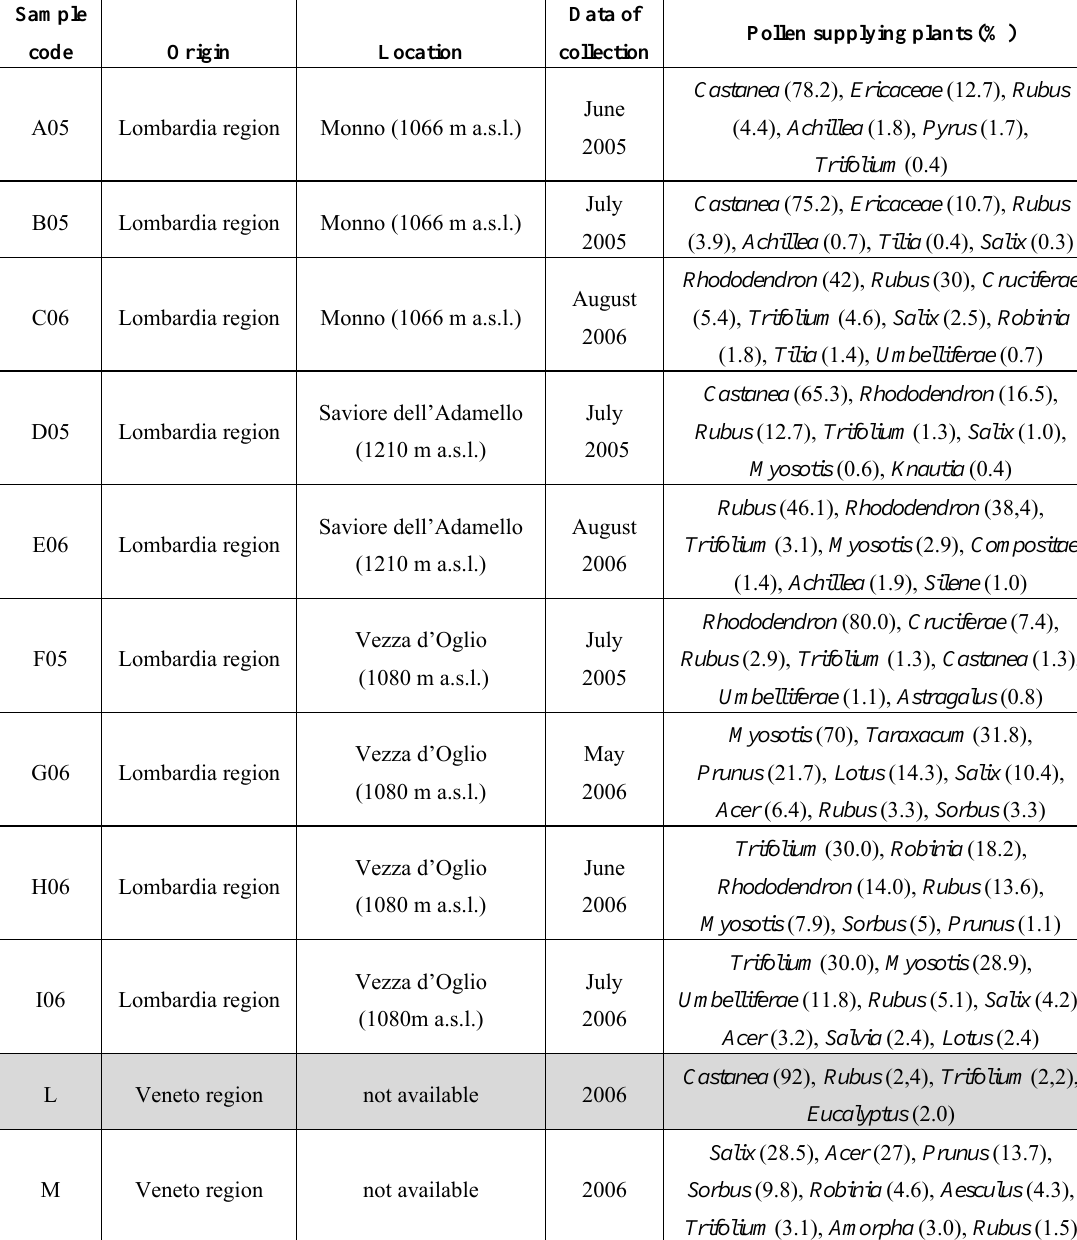
Table 1. List of samples, sample codes, region of origin, locations, data of collection, and percentages of the most important pollen supplying